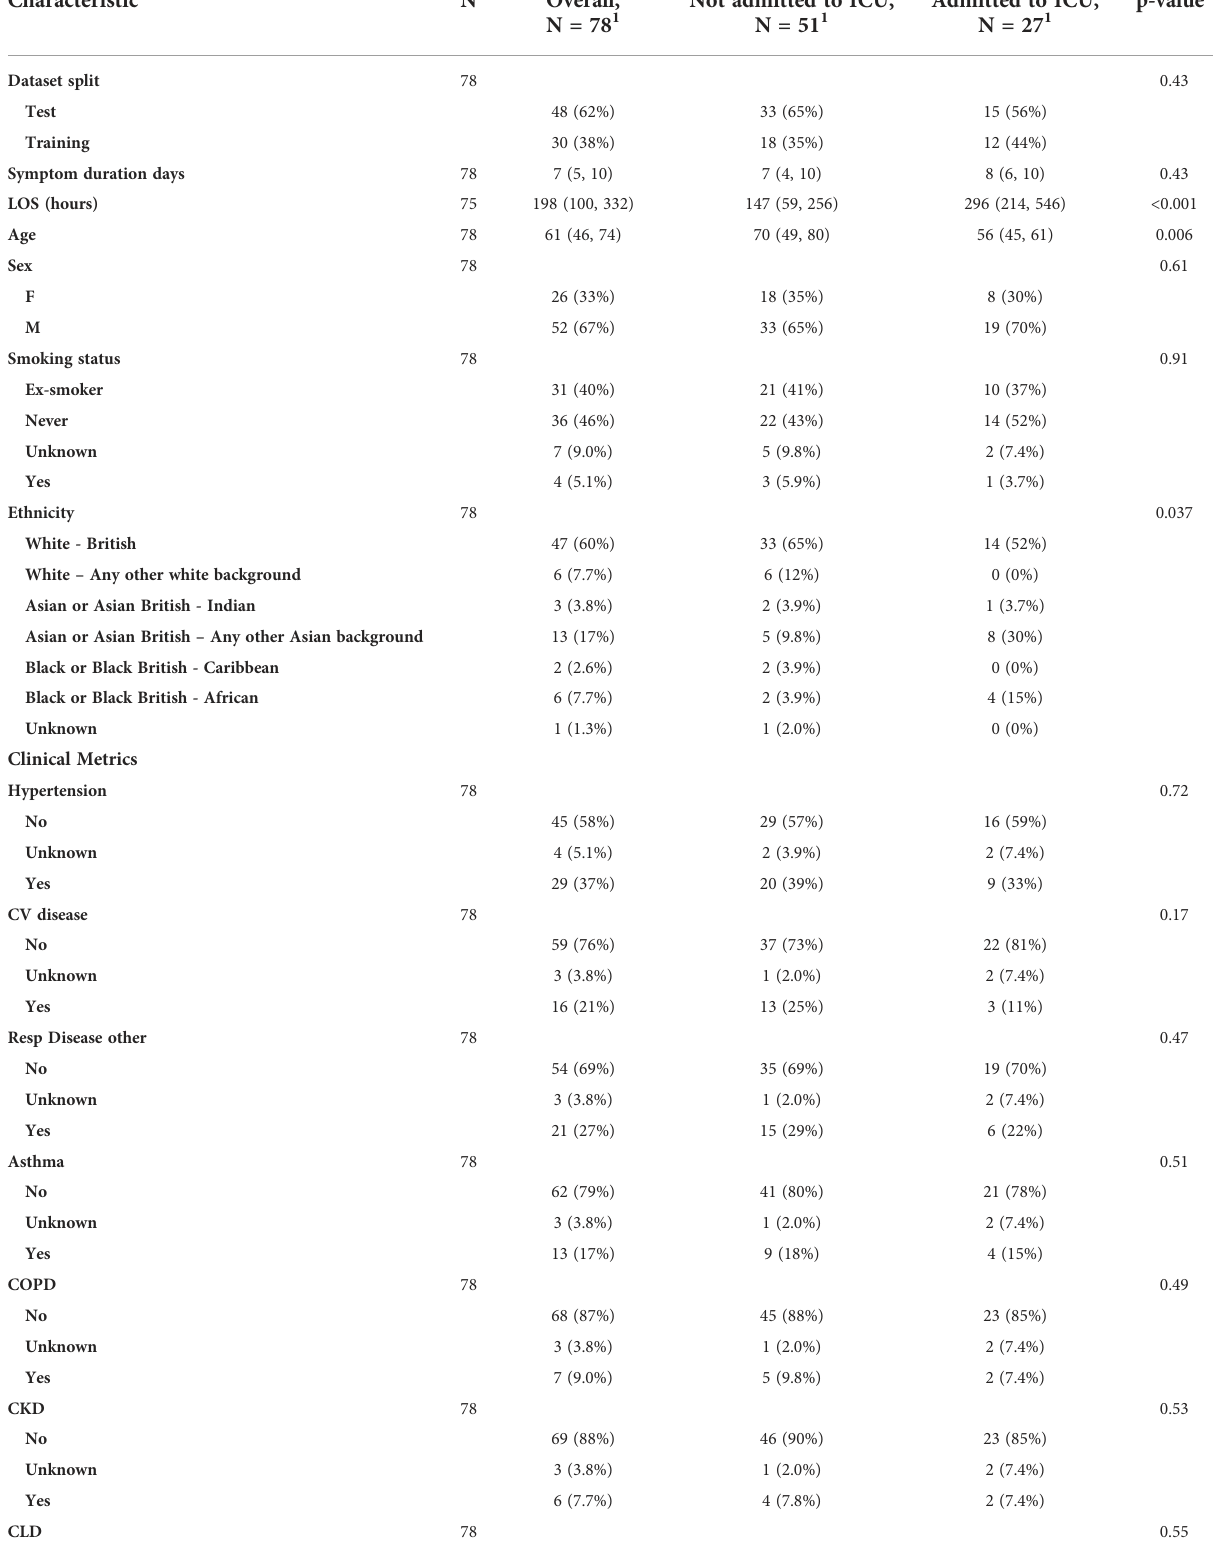
TABLE 1 Patient characteristics and demographics grouped by ICU admission